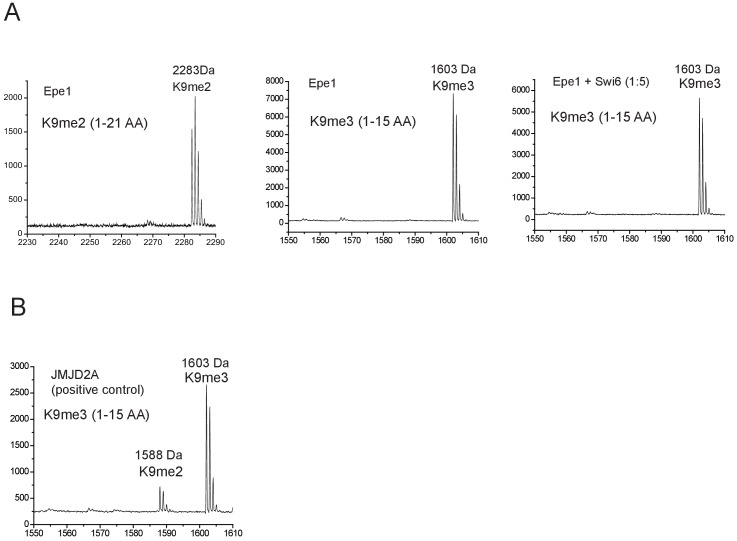
Epe1 exhibits no enzymatic activity in the presence or absence of Swi6HP1.(A) Mass spectrometry analysis of modified H3 peptides following an in vitro demethylase assay. The H3K9me2 tail peptide spans 1-21 amino acids with an intact mass of 2283 Da. The H3K9me3 tail peptide spans 1-15 amino acids with an intact mass of 1603 Da. Demethylase assays were carried out in the presence and absence of Swi6HP1. (B) The positive control active demethylase, JMJD2A produces a 15kDa mass shift corresponding to the removal of a single methyl group. JMJD2A preferentially demethylates H3K9me3 peptides.